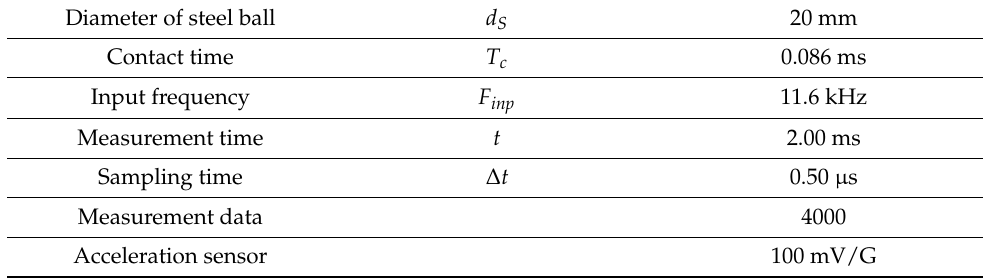
Table 5. Measurement